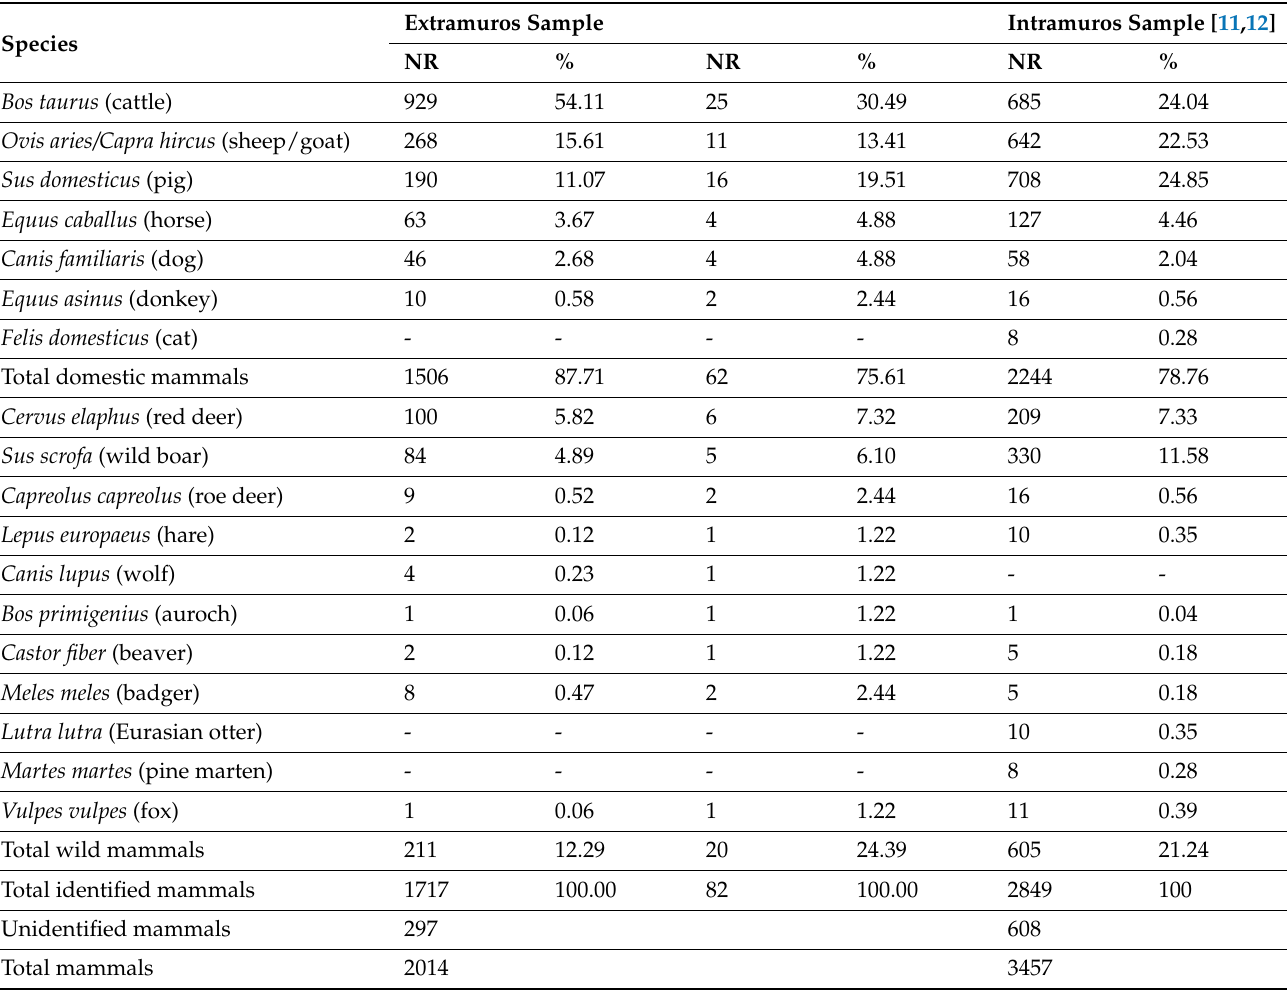
Table 4. Halmyris, Romania (4th–6th centuries AD). Quantification of mammal remains by NR and MNI (NR = number of remains; MNI = minimum number of